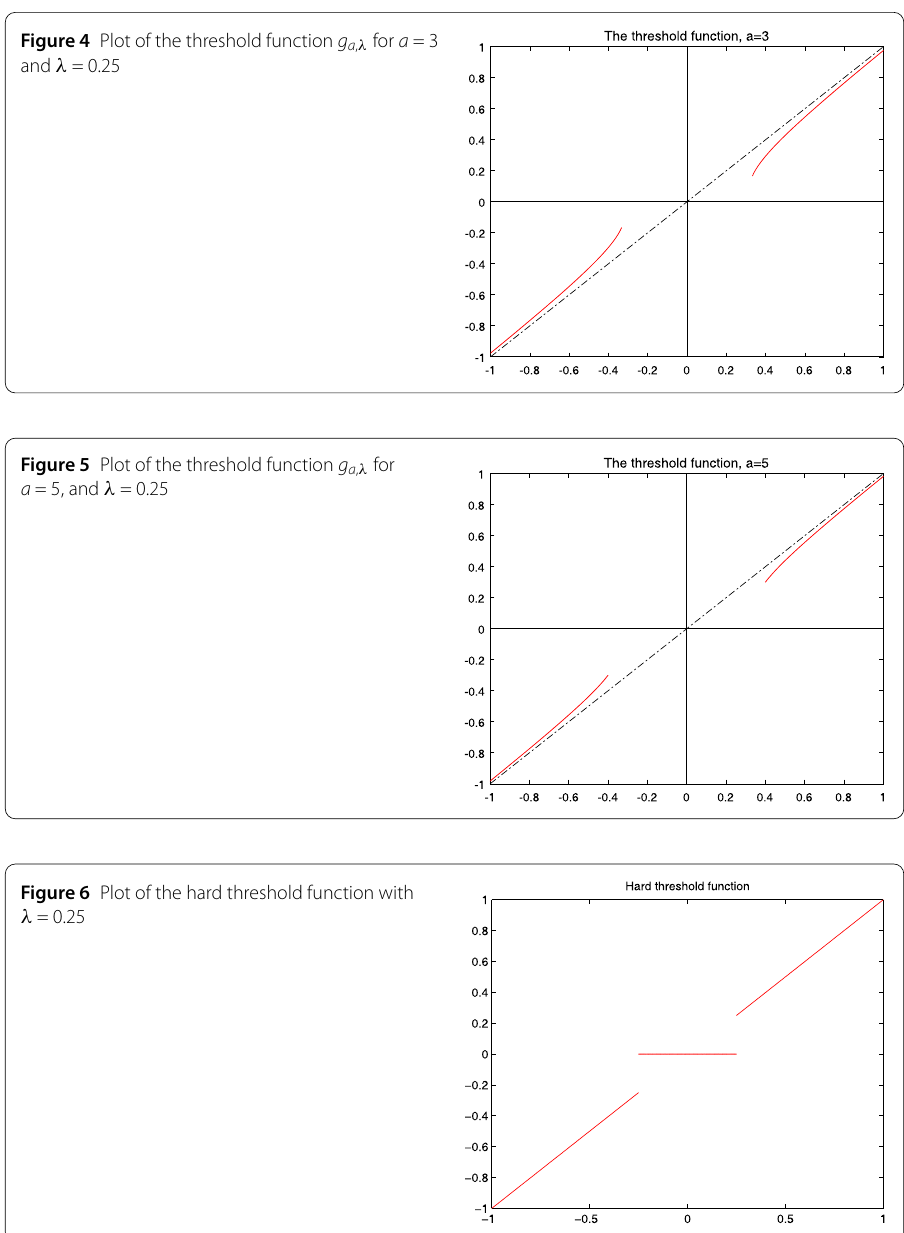
Figure 4 Plot of the threshold function g a , λ for a = 3 and λ = 0.25